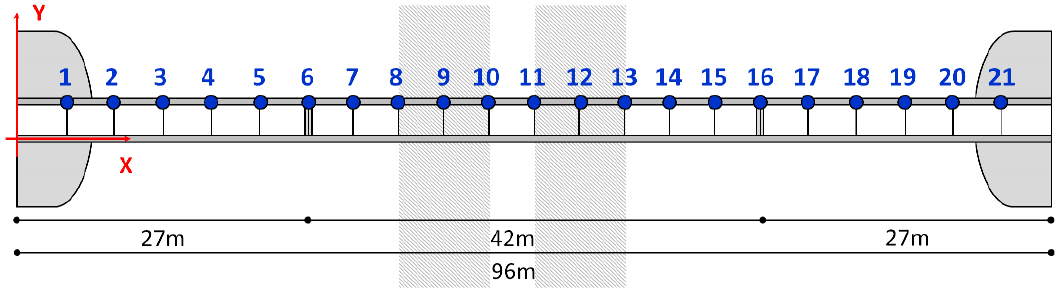
Figure 2. Plan view with indication of the position of the static cameras (blue dots), the highway (hatched areas) and orientation of the global axes (red